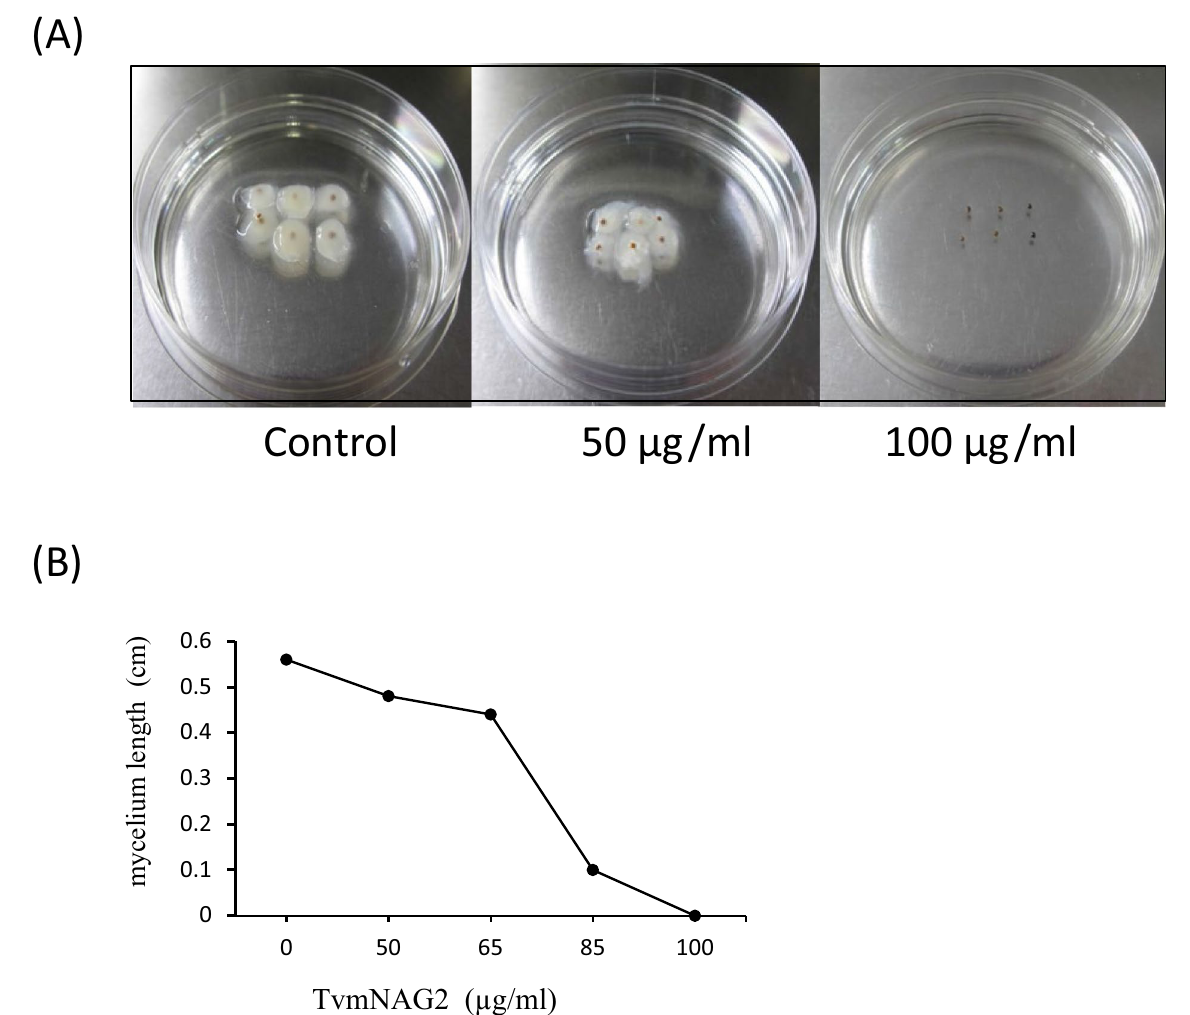
Fig. 8 Growth inhibition of S. rolfsii mycelium by TvmNAG2 . A The sclerotial bodies were grown in a medium containing TvmNAG2 at 50 or 100 µg/ ml overnight. Then, the sclerotial bodies was placed on the plates, and recorded. Control, without any TvmNAG2. B The effect of TvmNAG2 at 0–100 µg/ml on the mycelium length of S. rolfsii was studied